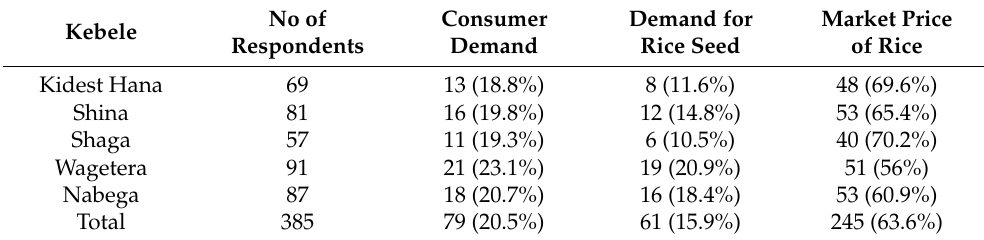
Table 3. Motivating factors for farmers to produce more rice in the Fogera floodplain.